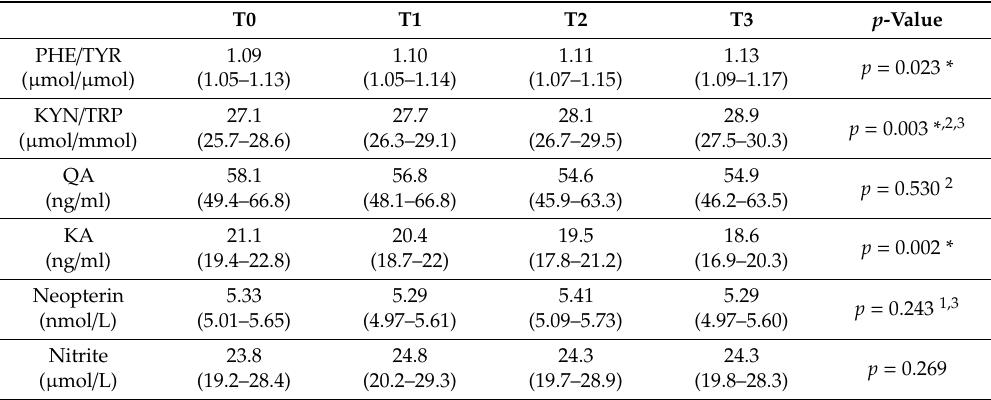
Table 2. The e ff ect of acute mental stress on neurotransmitter precursor amino acid levels, derived biogenic amines, neopterin and nitrite.